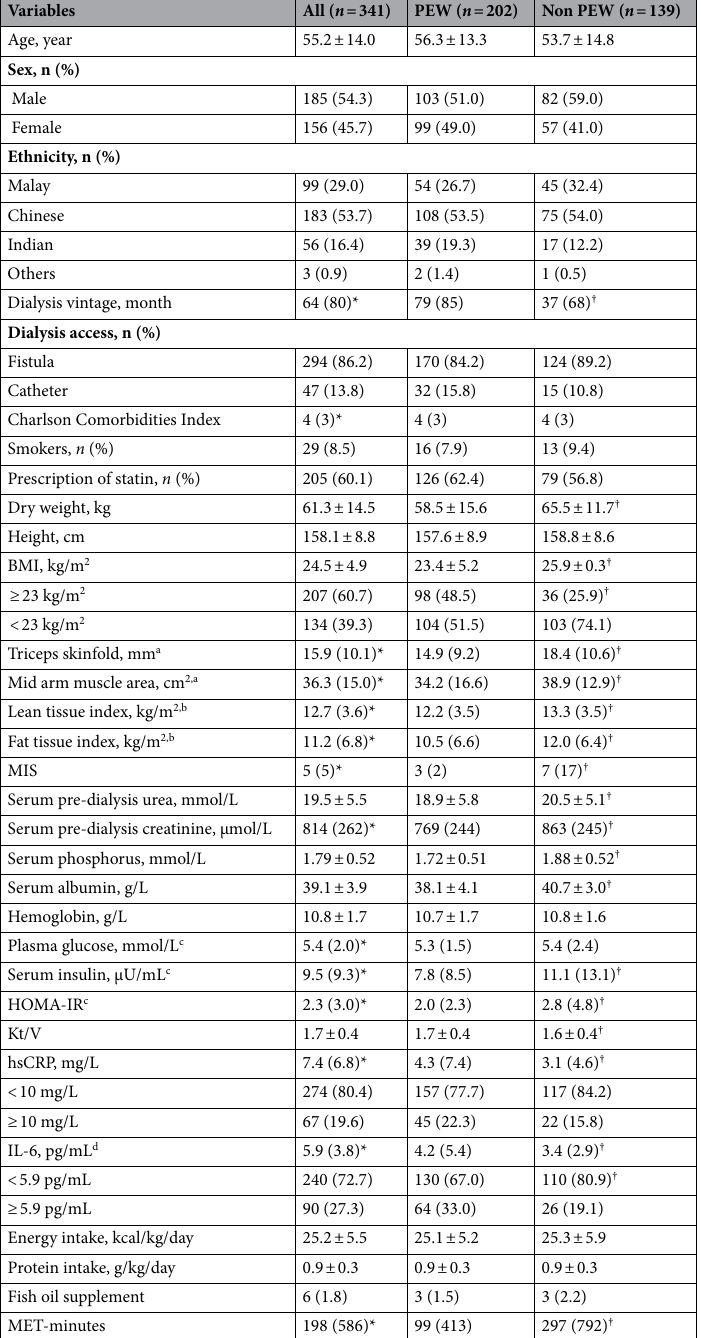
Table 1. Patient baseline characteristics and comparison between patients with and without protein-energy wasting. Protein energy wasting is defined as malnutrition inflammation score ≥ 5. *Values are expressed as median (interquartile range). † Analyses indicate p value < 0.05 for comparison between patients with and without protein-energy wasting based on independent t -test, Mann–Whitney test, or Chi-square test. a n = 340, b n = 336, c n = 304, d n = 331. hsCRP, high-sensitivity C-reactive protein; HOMA-IR, homeostatic model assessment of insulin resistance; IL-6, interleukin-6; MET, metabolic equivalent; MIS, malnutrition inflammation score; PEW, protein-energy